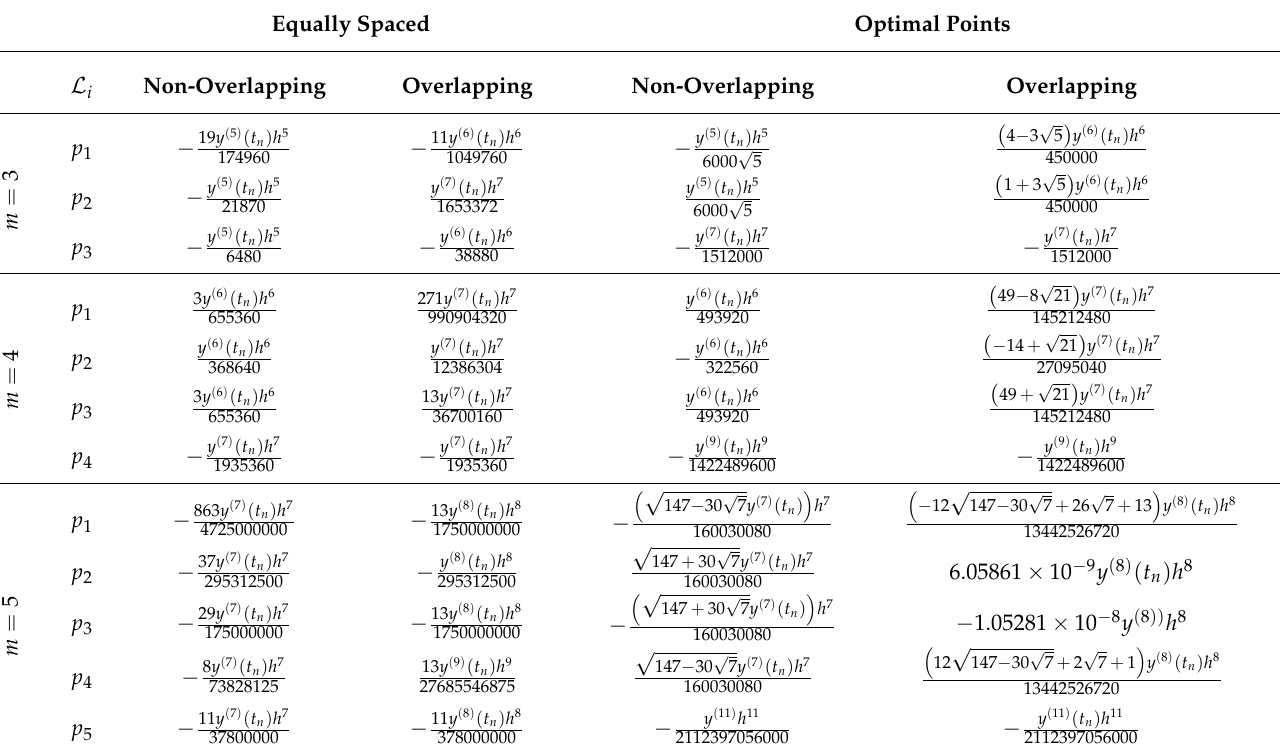
Table 1. Truncation errors for the overlapping and non-overlapping HBM with equally spaced and optimal intra-step